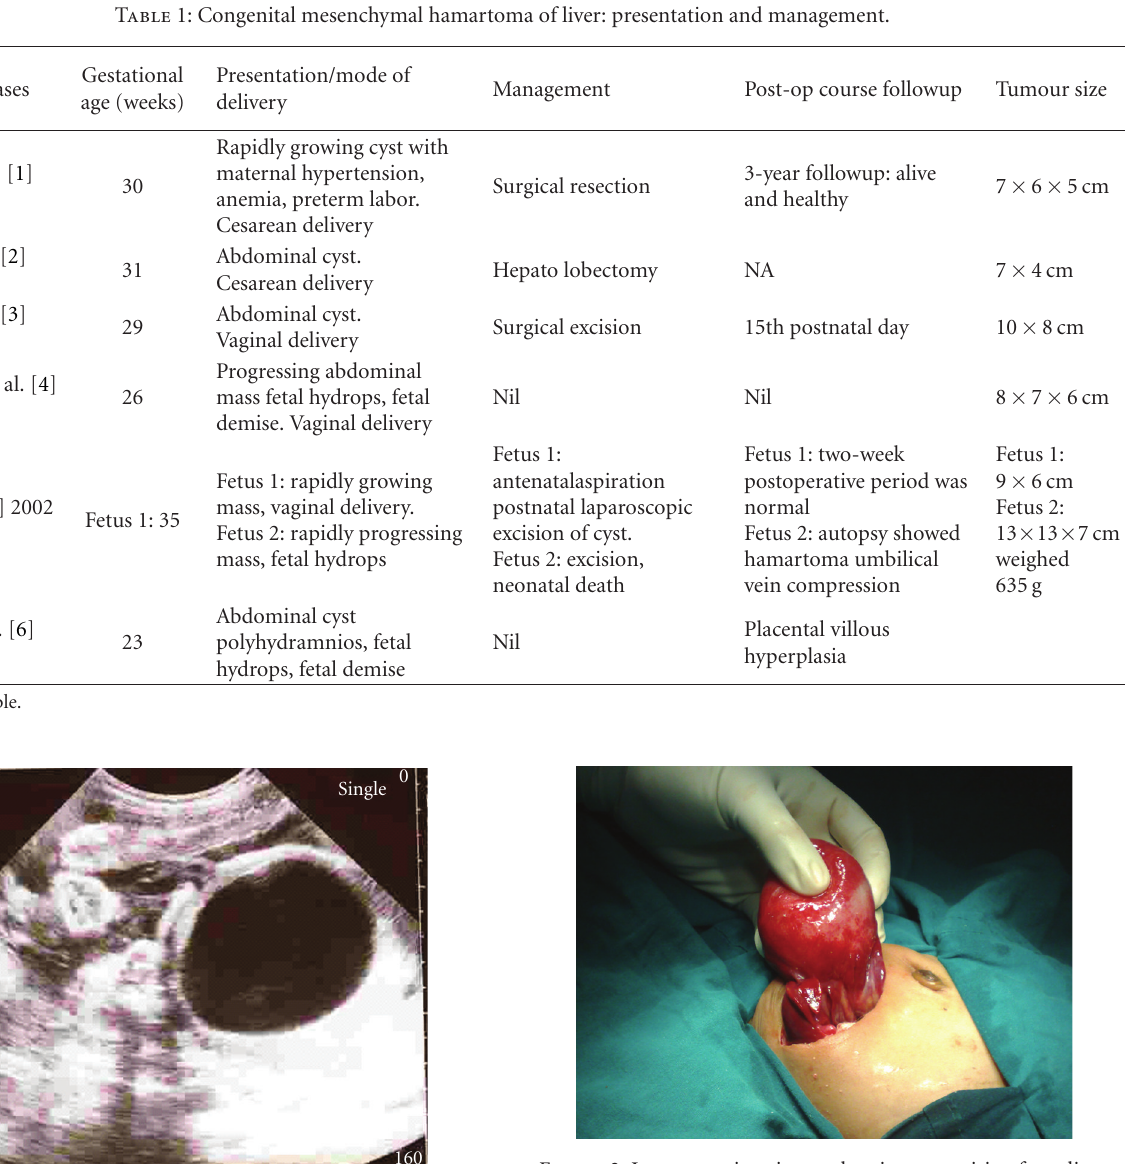
Figure 2: Intraoperative picture showing cyst arising from